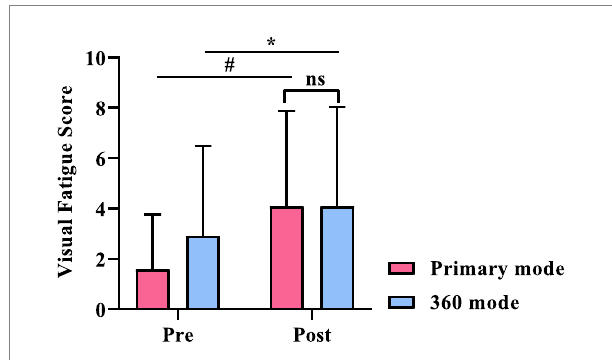
FIGURE 2 The changes in Visual Fatigue Score before and after the experiment. * indicates p < 0.05. # indicates p <